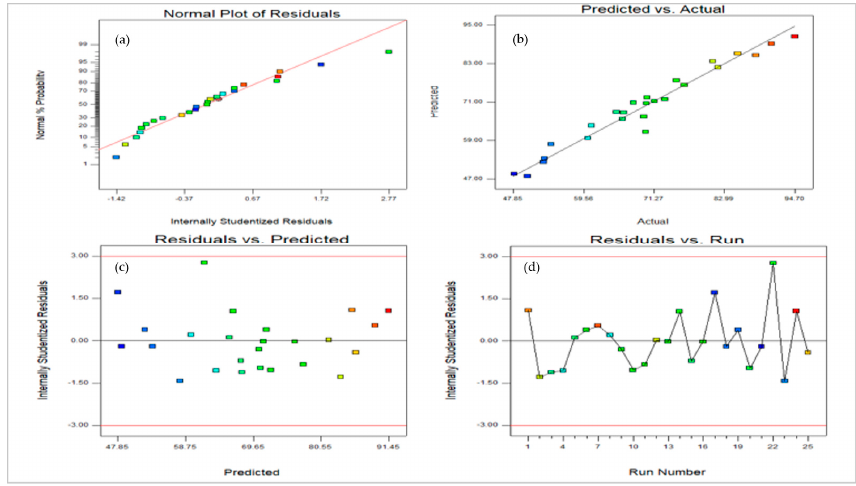
Figure 7. Model adequacy checking by examining ( a ) the normal probability of residuals, ( b ) the predicted vs. actual, ( c ) the independence residuals on run, and ( d ) the independence residuals on predicted